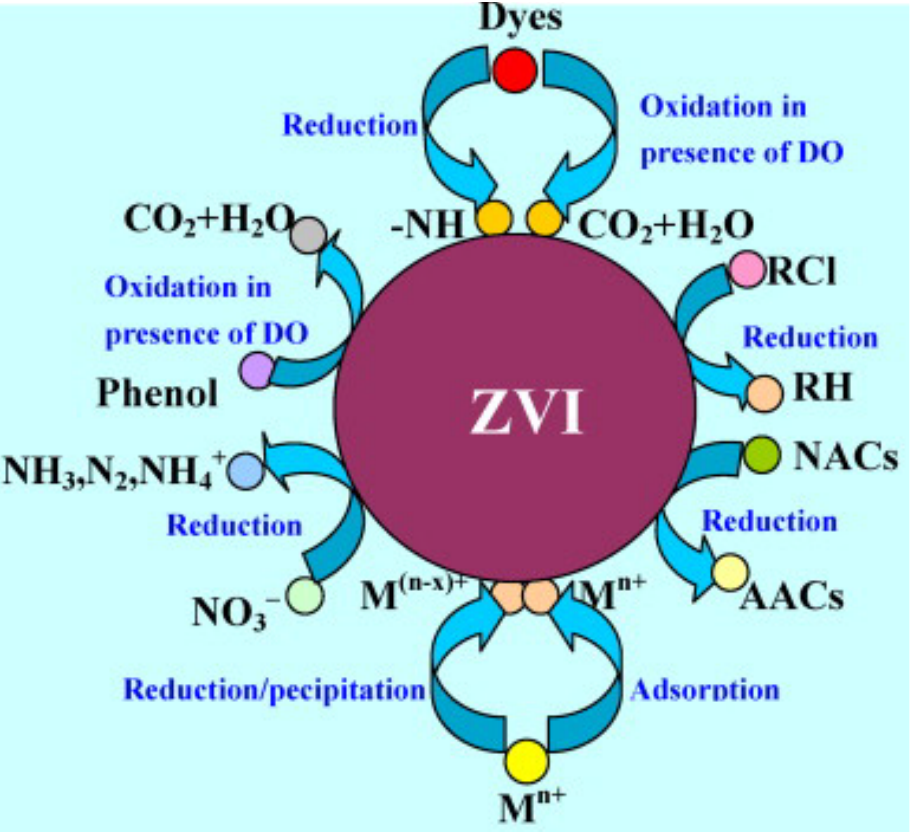
Figure 1. Schematic diagram for pollutant removal in ZVI systems (Reprinted from Fu et al. [8] with the permission from Elsevier).